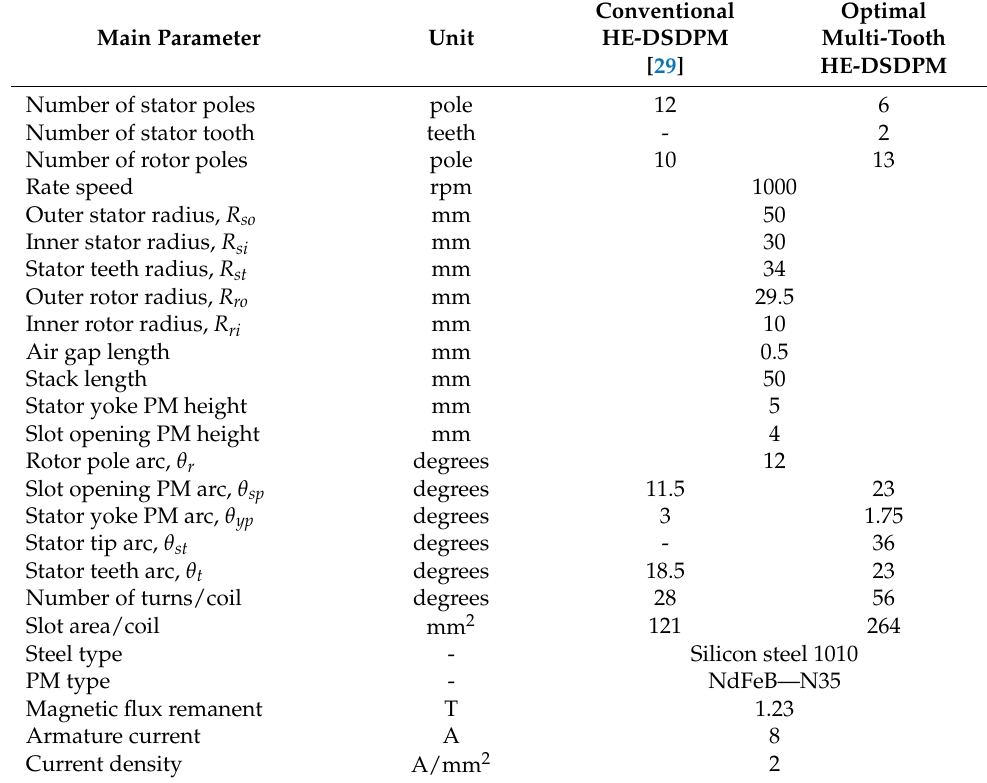
Table 2. Design specifications of optimal multi ‐ tooth HE ‐ DSDPM and conventional HE ‐ DSDPM Main Parameter